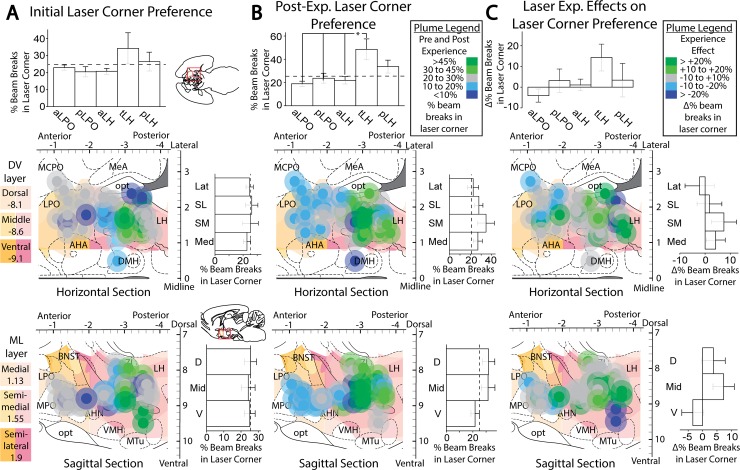
Anatomical localization of place-based self-stimulation.Fos plume maps demonstrating place-based laser self-administration in ChR2 subjects prior to (A), after (B), and due to (C) induction. Data depict percent of total entries or movements in laser-delivering corner versus other corners; dotted lines represent levels due to chance. Figure conventions and abbreviations are similar to previous mapping figures. Bar graphs represent laser corner entries for different anatomical subregions. *: p < 0.05, **: p < 0.01.